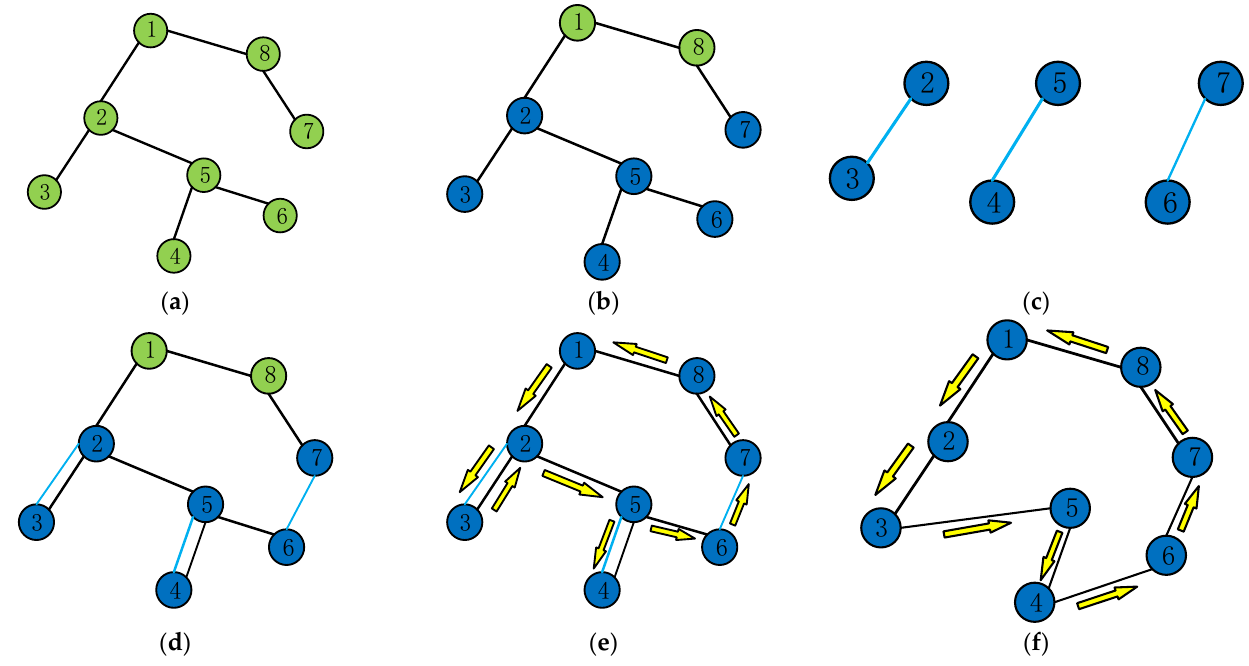
Figure 5. Example of Christofides’s heuristic algorithm. ( a ) Minimum spanning tree T , ( b ) blue points are odd degrees in set O , ( c ) minimum perfect matching R , ( d ) re-graph I , ( e ): Euler circuit X and ( f ) final path S.